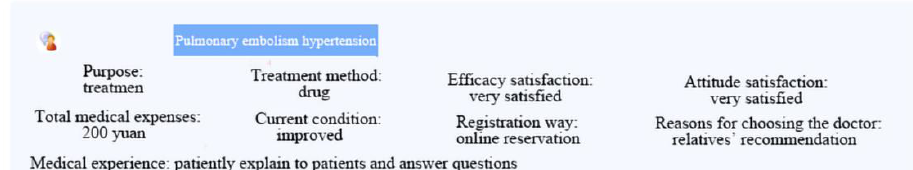
Figure 2. Doctor patient review section.